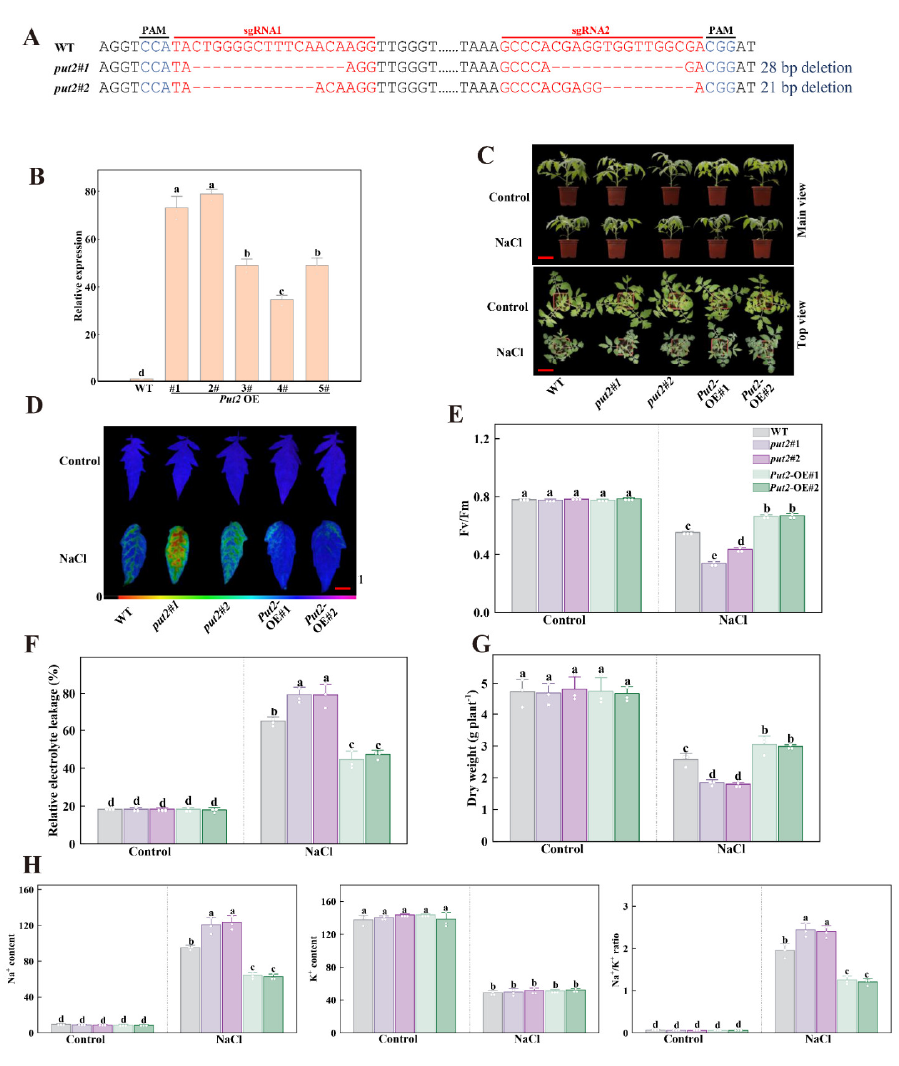
Figure 5. Put2 positively regulates salt tolerance. ( A ) Genotyping of mutations in put2#1 and put2#2 . Red letters indicate the target sites, ‘-’ represent sequence deletion, and blue letters represent the protospacer adjacent motif (PAM). ( B ) qRT-PCR analysis of Put2 transcript levels in WT and Put2 OE (1#, 2#, 3#, 4# and 5#). ( C ) Phenotypes of WT, put2 mutants, or Put2 OE lines after exposure with or without salt stress for 7 days. ( D ) Fv/Fm in WT, put2 mutants, or Put2 OE lines leaves after exposure with or without salt stress for 7 days. The false-color code depicted at the bottom of image range from 0 (black) to 1.0 (purple), showing the level of damage in the leaves. ( E ) Quantitative analysis of Fv/Fm as shown in ( D ). ( F ) The relative electrolyte leakage and ( G ) dry weight in WT, put2 mutants, or Put2 OE lines after exposure with or without salt stress for 7 days. ( H ) Ion content and Na + /K + ratio in shoots of WT, put2 mutants, or Put2 OE lines after exposure with or without salt stress for 7 days. Data are presented as mean values ± SD; n = 3. Different letters indicate significant differences between treatments ( p < 0.05, Duncan’s multiple range test). At least three independent experiments were